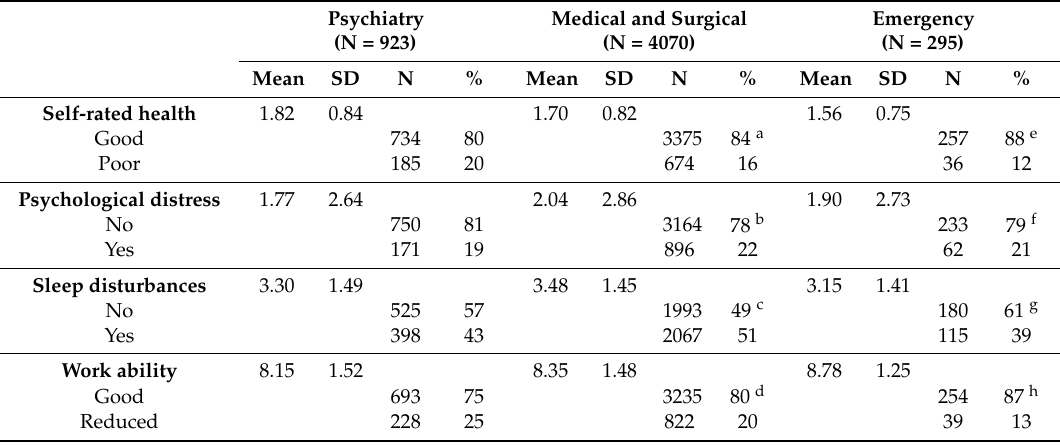
Table 4. Comparison of nurses’ wellbeing in different settings (Finland, 2012). Psychiatry Medical and Surgical (N = 923) (N =